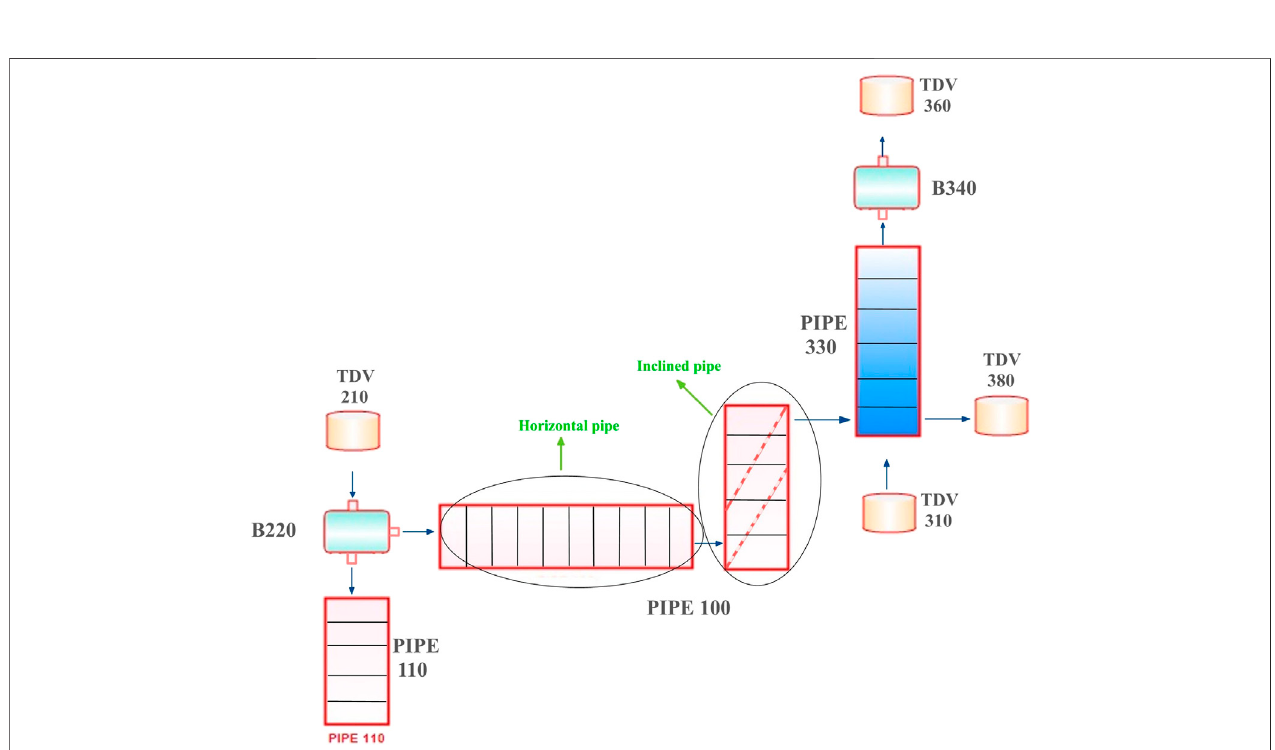
FIGURE 5 | Nodes division